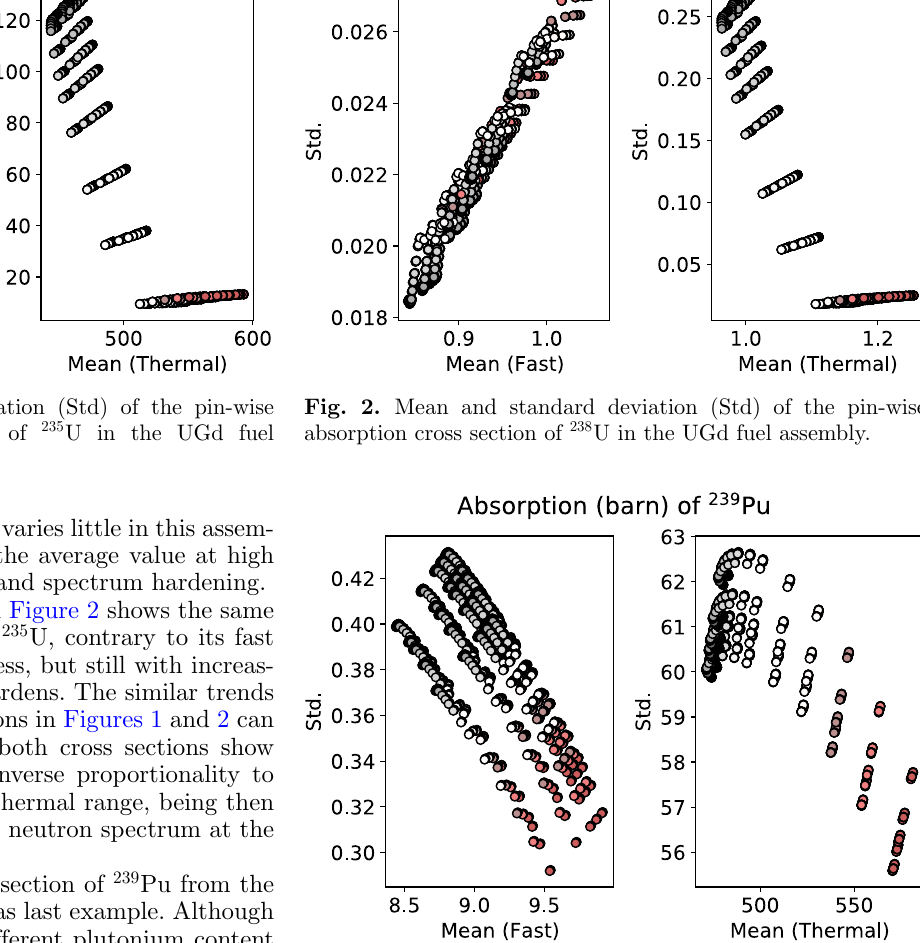
Fig. 3. Mean and standard deviation (Std) of the pin-wise absorption cross section of 239 Pu in the MOX fuel assembly.